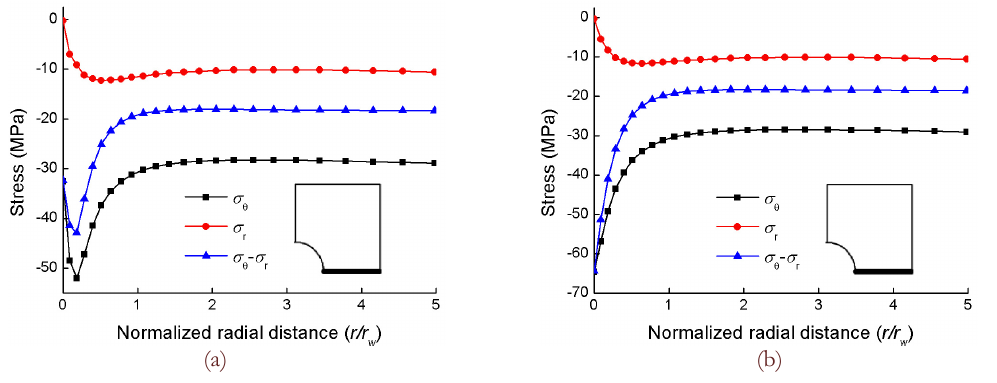
c =12 MPa; (b) c =50 m m